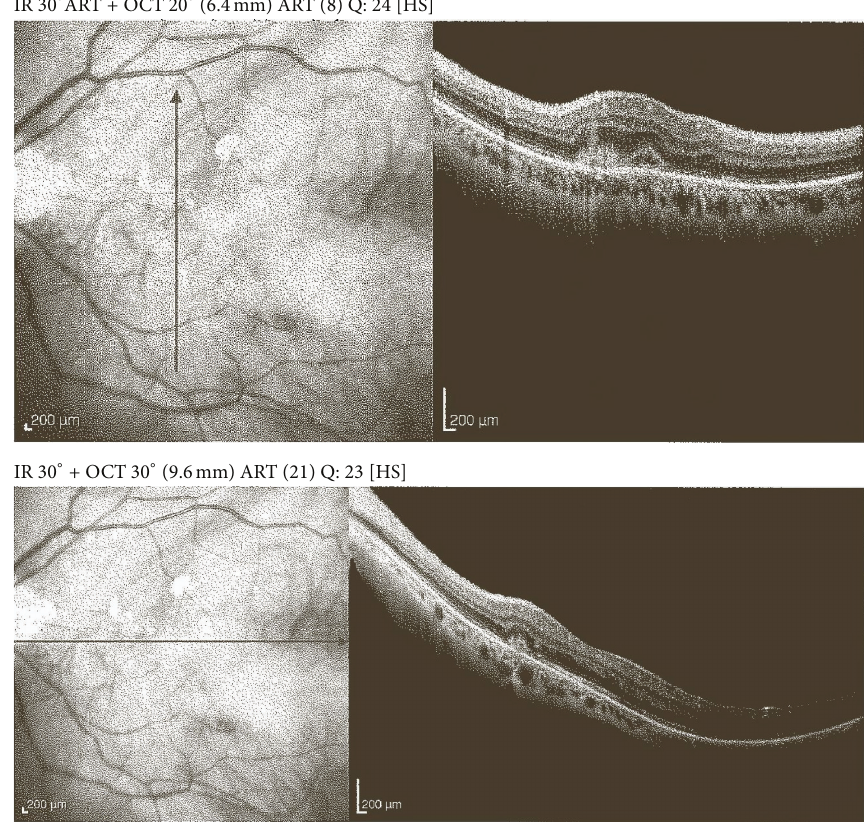
Figure 1: Retinal degeneration shortly after the onset of the hemorrhage.